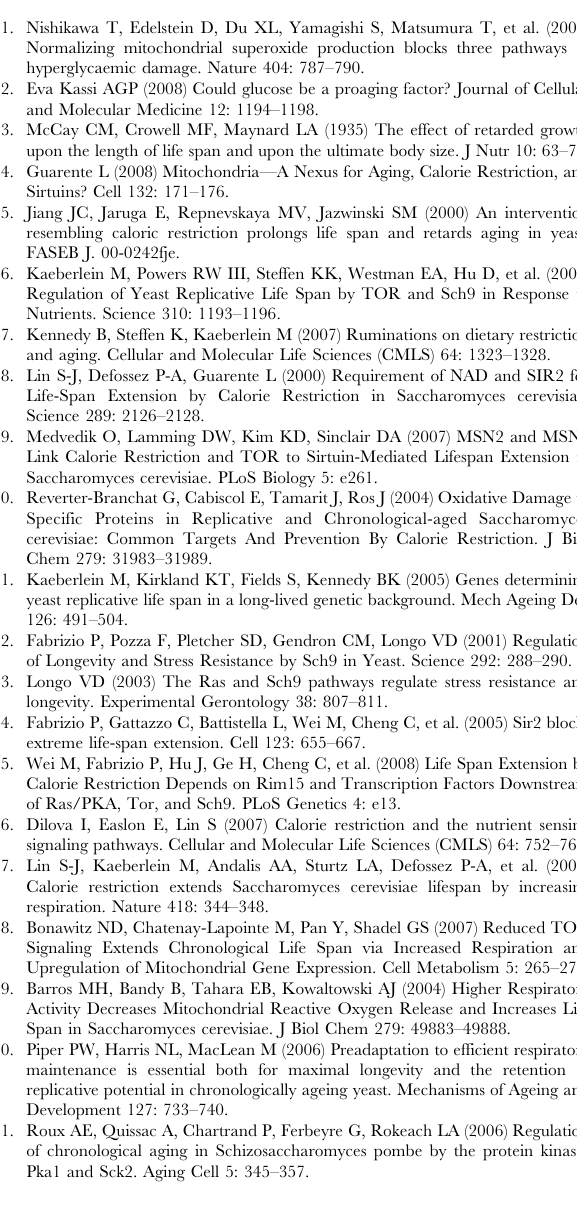
Table S1 Strains used in this study presented with their genotypes and the laboratory where they were created. * refers to strains created for this